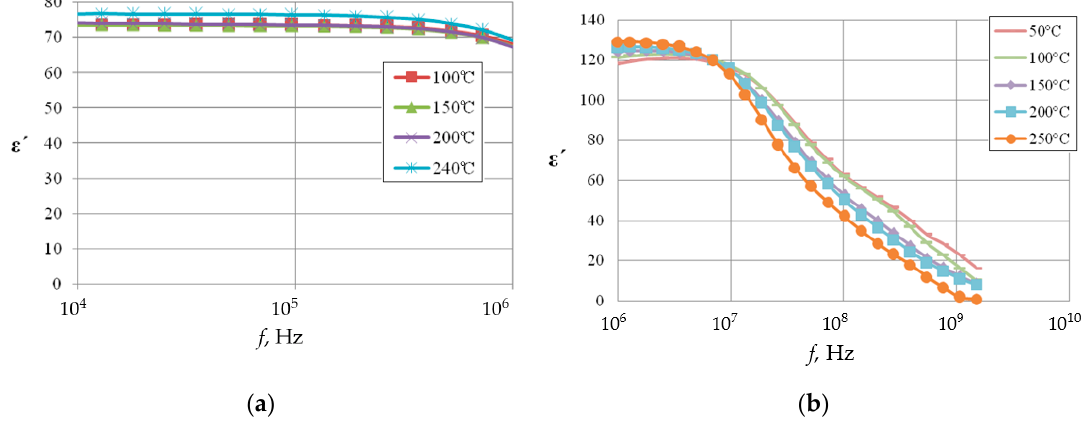
Figure 6. Frequency dependences of dielectric permittivity of composite coatings PZTNB-1/PBO, heat-treated at 250 °C ( a ) and 300 °C ( b ). heat-treated at 250 ◦ C ( a ) and 300 ◦ C ( b